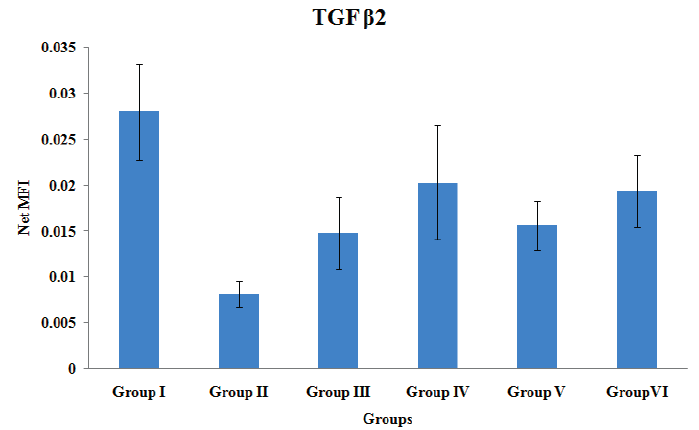
Figure 6. TGF β 2 Gene Expression. Samples were normalized to GAPDH MFI (Median Fluorescence Intensity). Values were expressed as mean ± SEM. Group I: